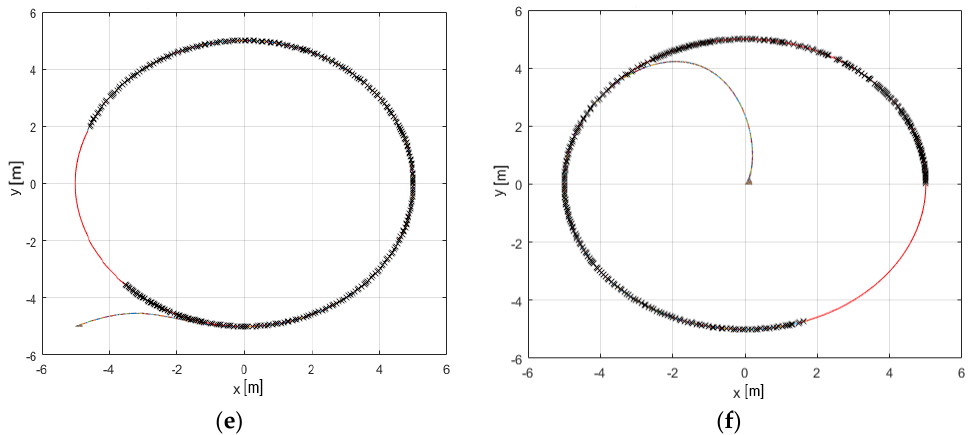
Figure 10. Different path simulation: ( a ) Sinusoidal with AGV at the right side; ( b ) Sinusoidal with AGV at the left side; ( c ) Linear with AGV at the right side; ( d ) Linear with AGV at the left side; ( e ) Circular with AGV outside; ( f ) Circular with AGV inside.